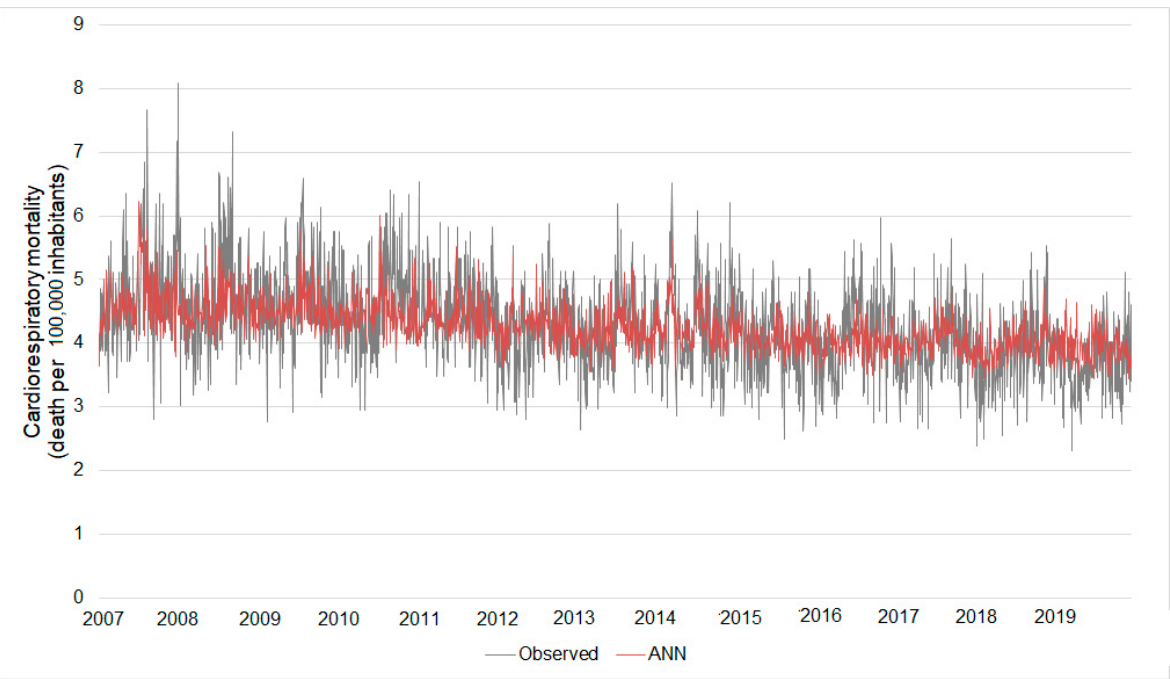
Figure 6. Real daily cardiorespiratory mortality versus that estimated by the Model II ANN. Results considering the ANN build from the rainy season database.